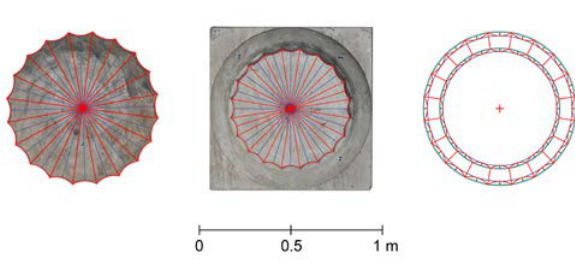
Figure 4.Left and middle: Tracing of flutes on the lower and upper diameter of the column, measuring of inner diameters (blue lines) and reconstruction of outer diameter (red lines). Right: Reconstruction of the column shaft using the